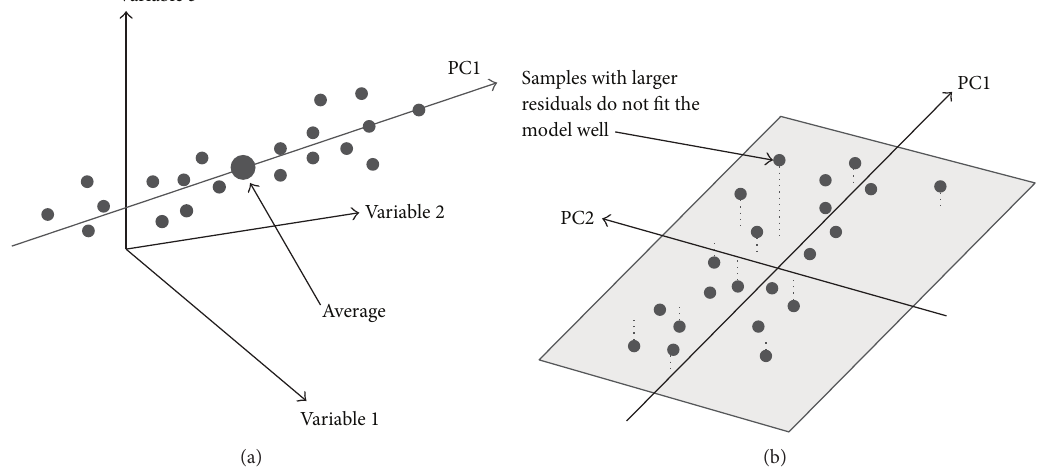
Figure 4: Illustration of principal component coordinates (a) and residues